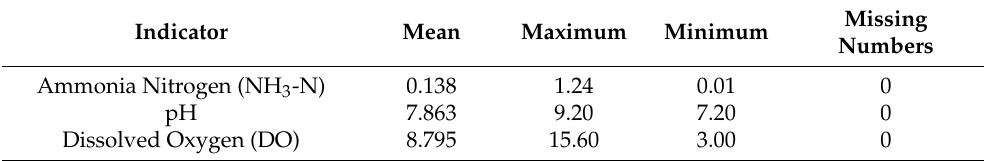
Table 1. Description of three water quality